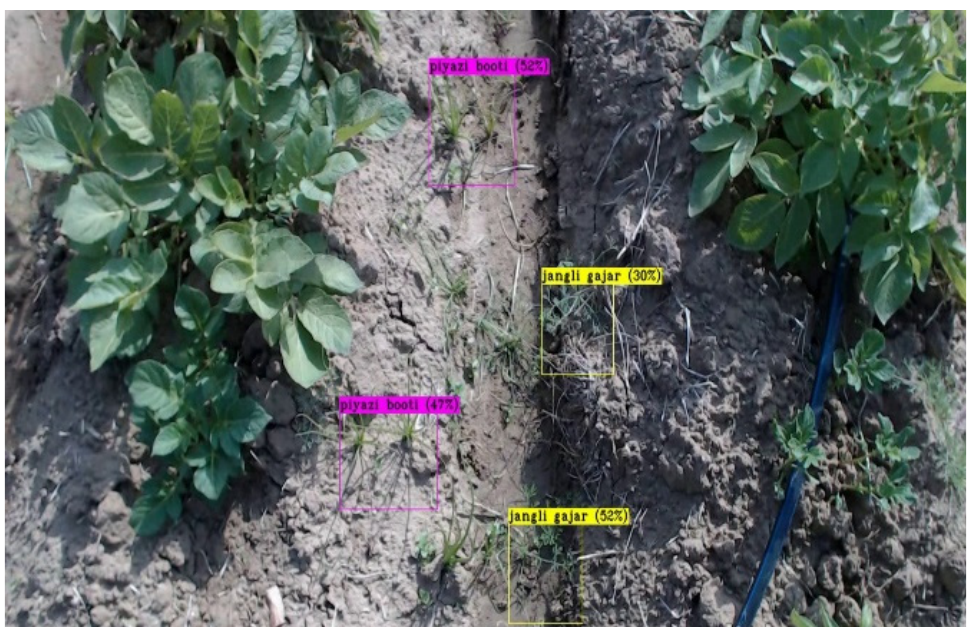
Figure 3. Real-time detection results of the Tiny-YOLOv4 model.